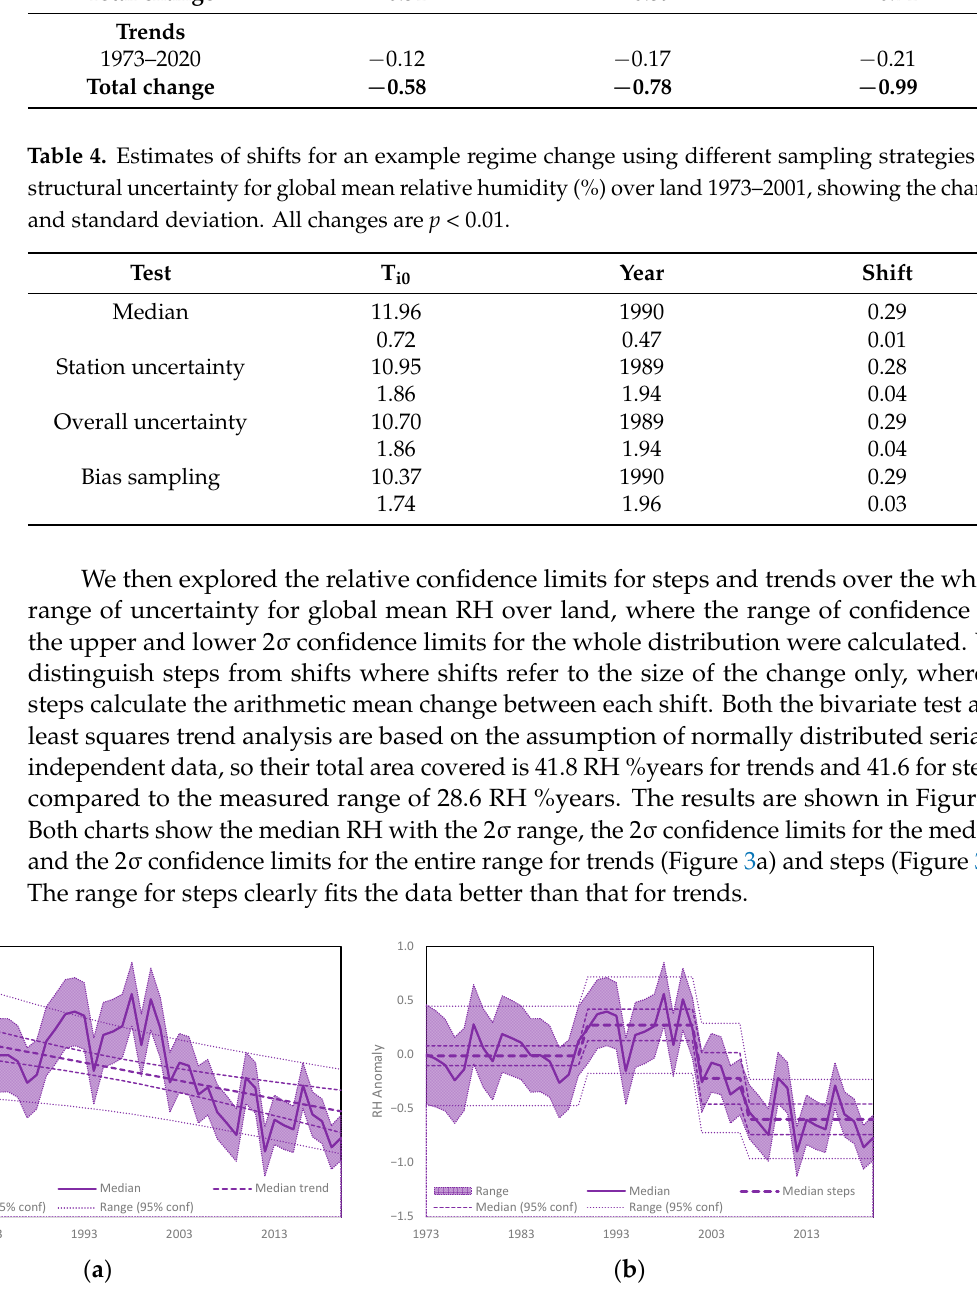
Figure 3. Median annual anomalies (1981–2010) and the 2 σ uncertainty range (shaded area) showing ( a ) the median trend with 95% trend confidence limits and the 95% annual anomaly range limits assuming change is gradual and ( b ) as for ( a ) but considered as regimes (1973–2020).